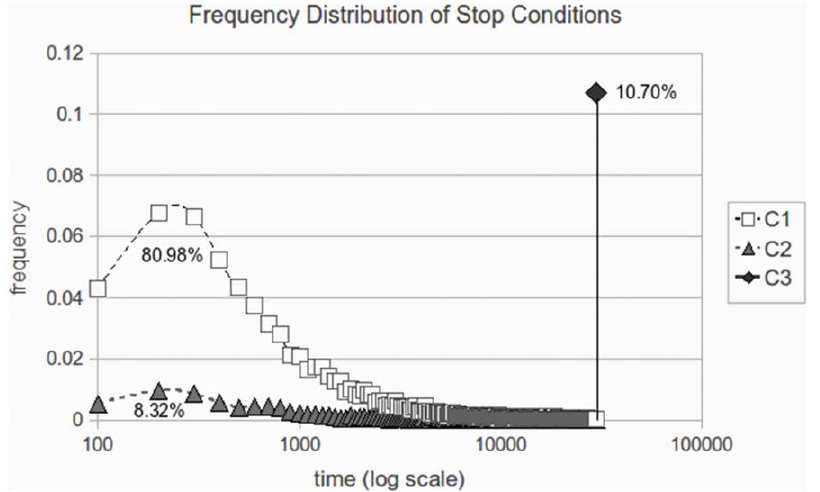
Figure 4. Frequency distribution of the stop conditions reached by 10.000 simulation runs. C1 represents the relative frequency of runs that reached one of the C1 stop conditions defined in section ‘Most Frequent Persistent Regimes’. C2 represents the frequency of runs that reached the C2 stop conditions defined in section ‘Isolated Bargaining Clusters’. This stop criterion extends the C1 conditions to disconnected interaction components that can randomly appear in the spatial distribution of agents on the grid. Finally C3 gathers the rest of the runs, which are analysed in section ‘Other Persistent Regimes’.